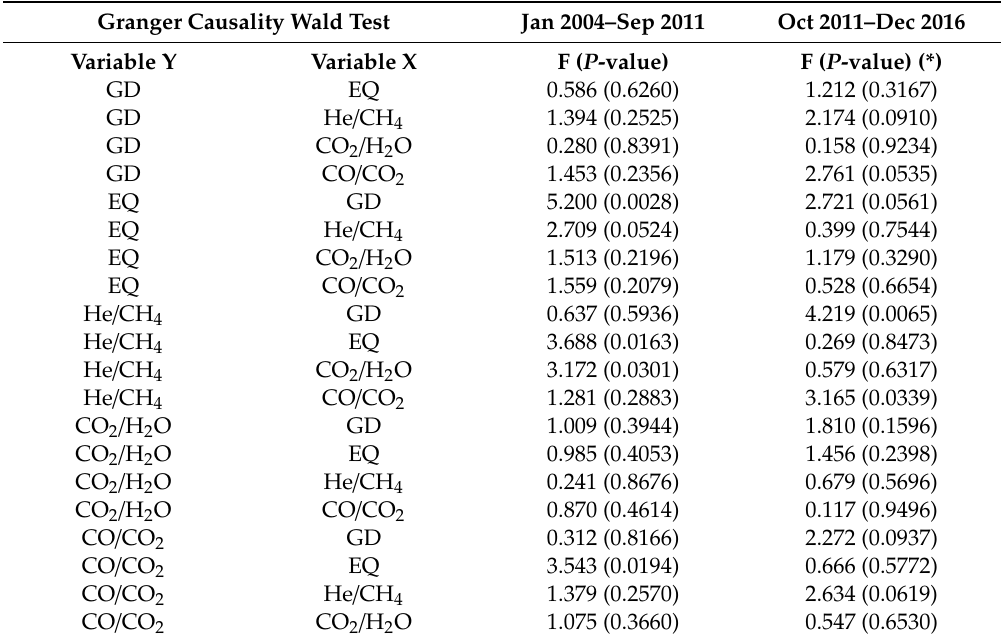
Table 1. Granger causality analysis in two di ff erent periods with null hypothesis that X does not Granger causes Y ((*) results obtained by di ff erentiating